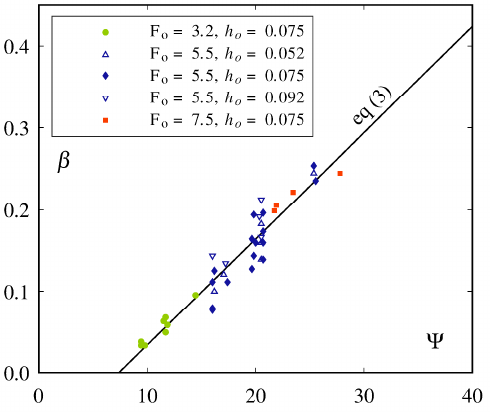
Figure 6. Air entrainment coefficient β as a function of Ψ = F o ·(1 + sin φ ) 1.5 ·(1 + tan α ) 3